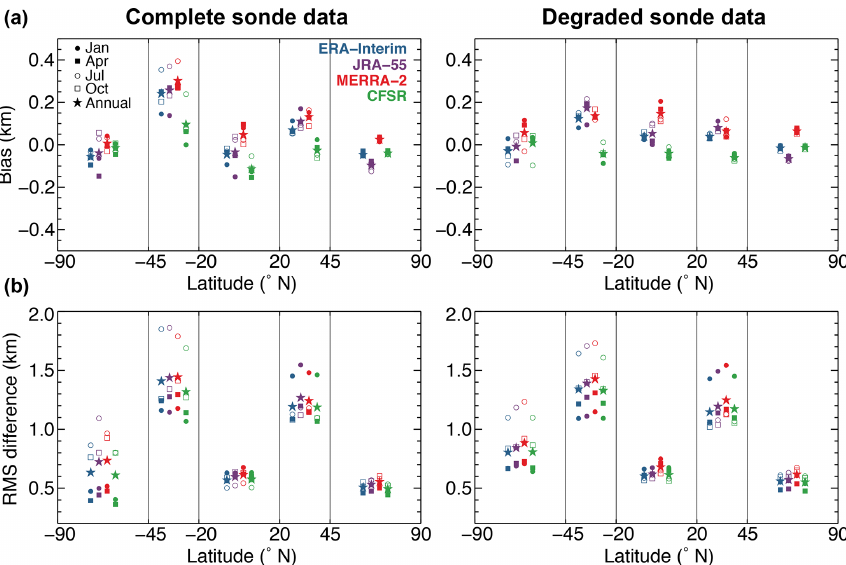
Figure 2. (a) Average bias and (b) root-mean-square differences in instantaneous primary tropopause altitudes between radiosonde and reanalyses within five latitude bands. Open and closed symbols show the statistics as a function of season, with January (July) given as closed (open) circles, April (October) given as closed (open) squares, and the annual values given as closed stars. Results for ERA-Interim are shown in blue, JRA-55 in purple, MERRA-2 in red, and CFSR in green. Latitude values along the x axis and vertical lines denote the boundaries of each latitude band. The number of radiosonde stations (profiles) used for each band are as follows: 113 (3 . 5 × 10 4 ) in the Northern Hemisphere extratropics (45–90 ◦ N), 152 (5 . 0 × 10 4 ) in the Northern Hemisphere subtropics (20–45 ◦ N), 25 (7000) in the deep tropics (20 ◦ S–20 ◦ N), 20 (5000) in the Southern Hemisphere subtropics (20–45 ◦ S), and 7 (2000) in the Southern Hemisphere extratropics (45–90 ◦ S). Results using the complete IGRA radiosonde observations are shown on the left and results following the degradation of IGRA profiles to the native vertical grid of each reanalysis prior to tropopause calculation are shown on the